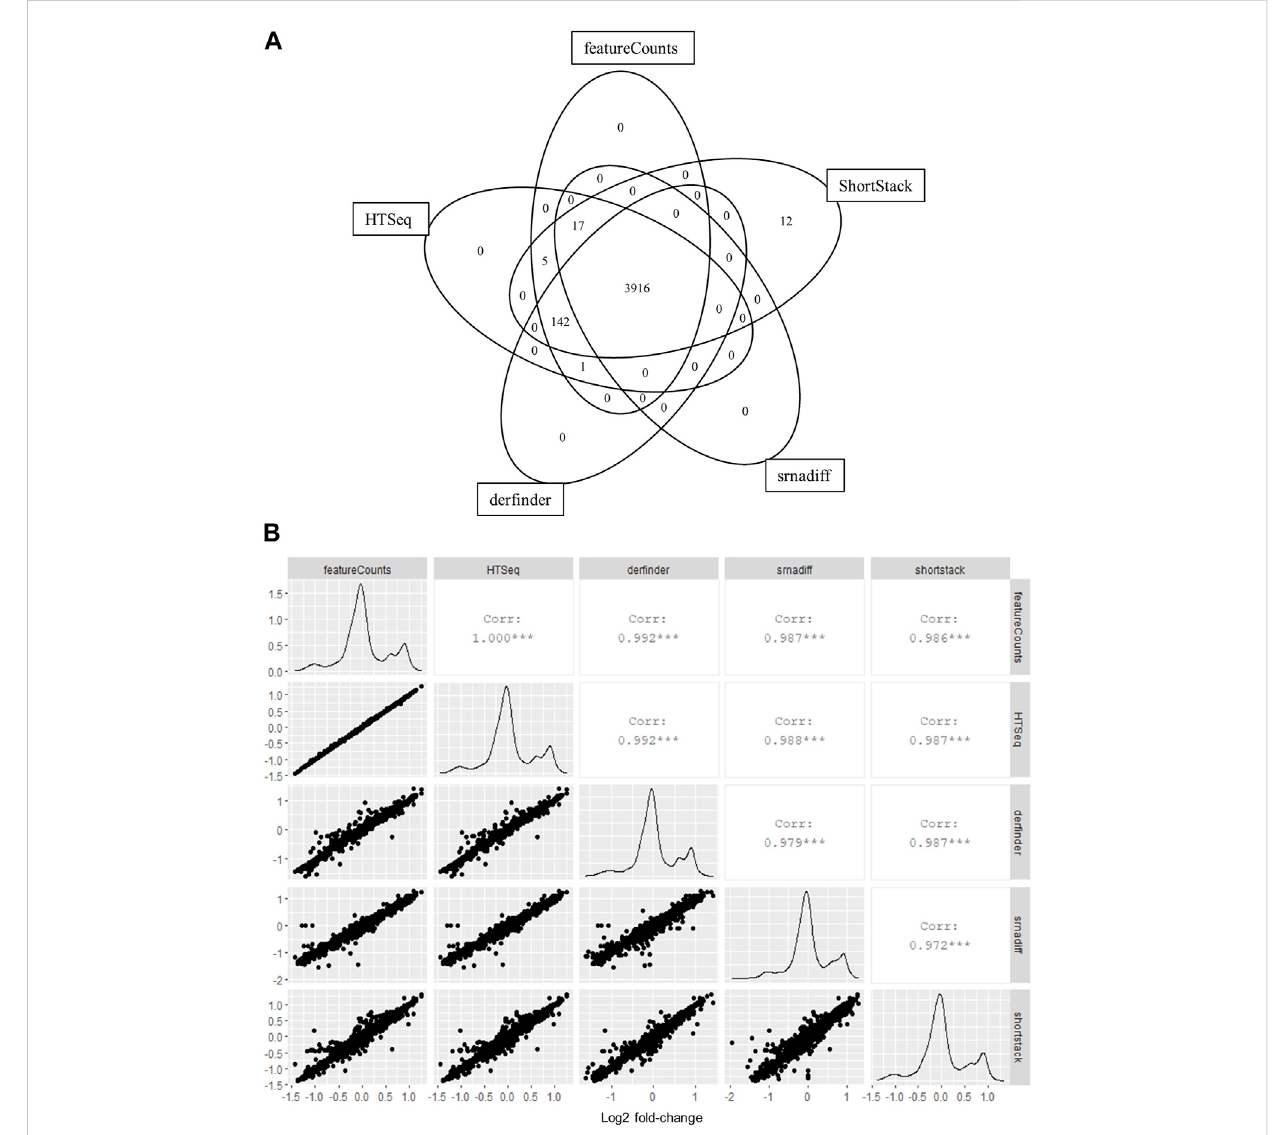
FIGURE 1 Annotation-agnostic tools yield similar results to other read summarization software for simulated RNA-seq experiments. (A) Number of features detected by each tool after low-expression fi ltering. A 12-sample small RNA-seq experiment was simulated using the polyester package for R. Two six- sample groups were assigned, with 20% of features showing a 2-fold upregulation, while another 20% were downregulated by 2-fold in the ‘ treatment ’ group.Readswerecountedonoverlappingfeatureswithder fi nderandShortStack,whilesrnadiffwasrunin “ annotation ” modeforcomparisonswith featureCounts and HTSeq. (B) Log2 fold-change values per gene were calculated between groups using edgeR and compared for each